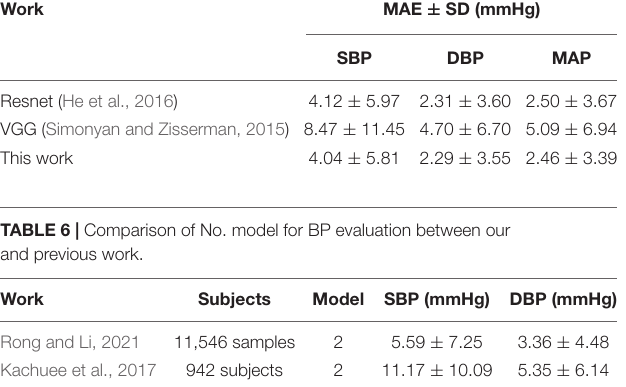
TABLE 5 | Comparison of predicted BP values between our and previous work based on our dataset from MIMIC-II. Work